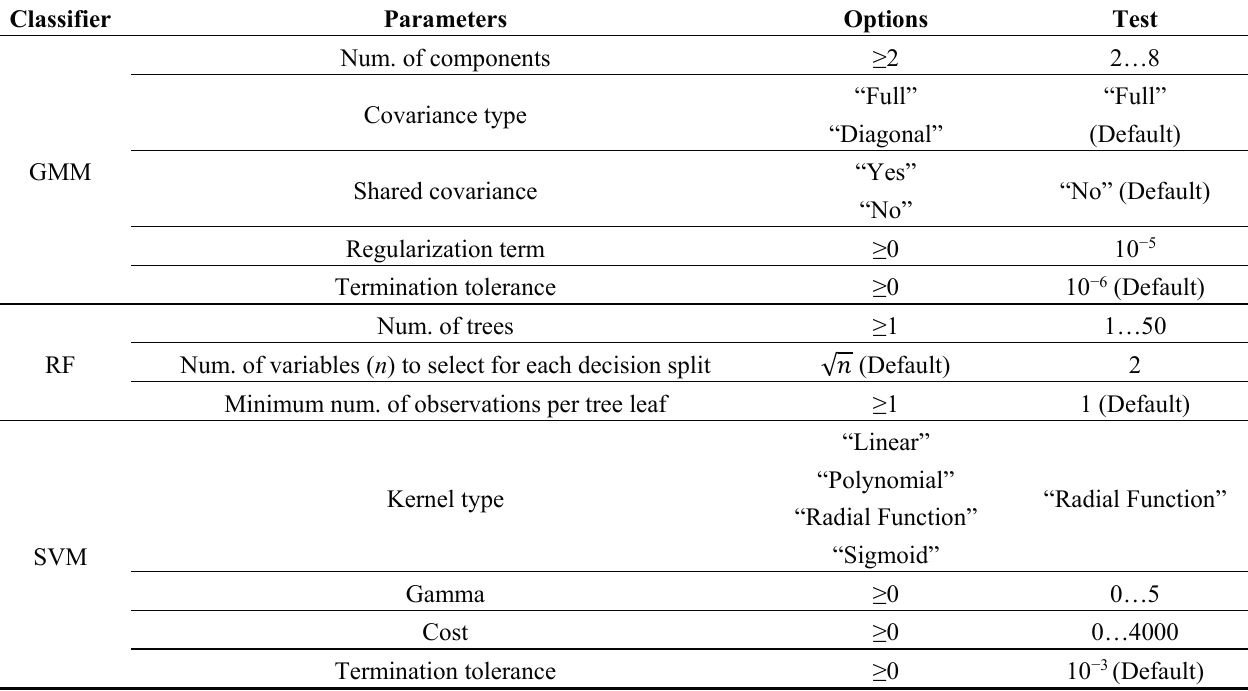
Table 5. Parameter test settings of each classifier without smoothing.